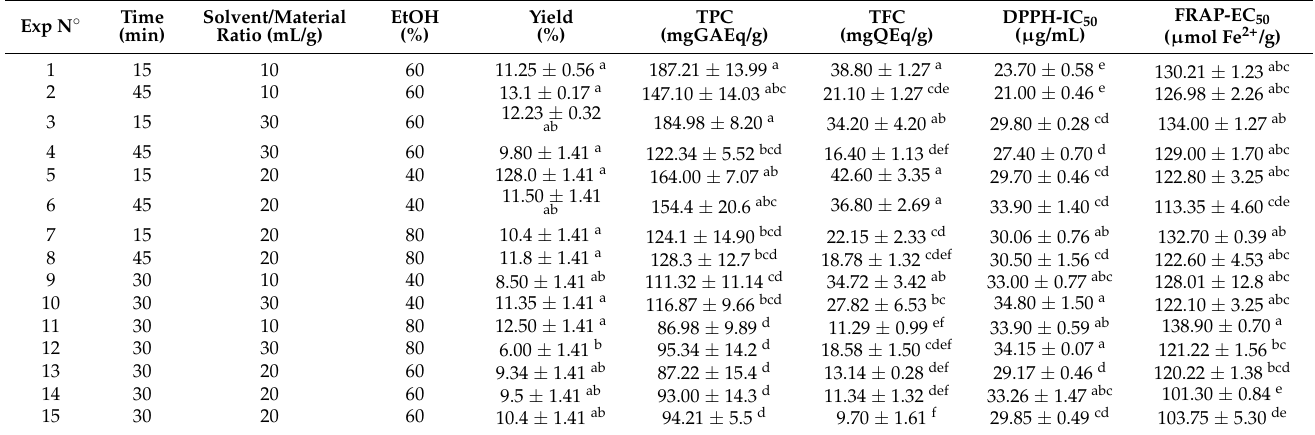
Table 2. Matrix of BBD and results for yield, total phenol content (TPC), total flavonoid content (TFC), DPPH-IC 50 , and FRAP-EC